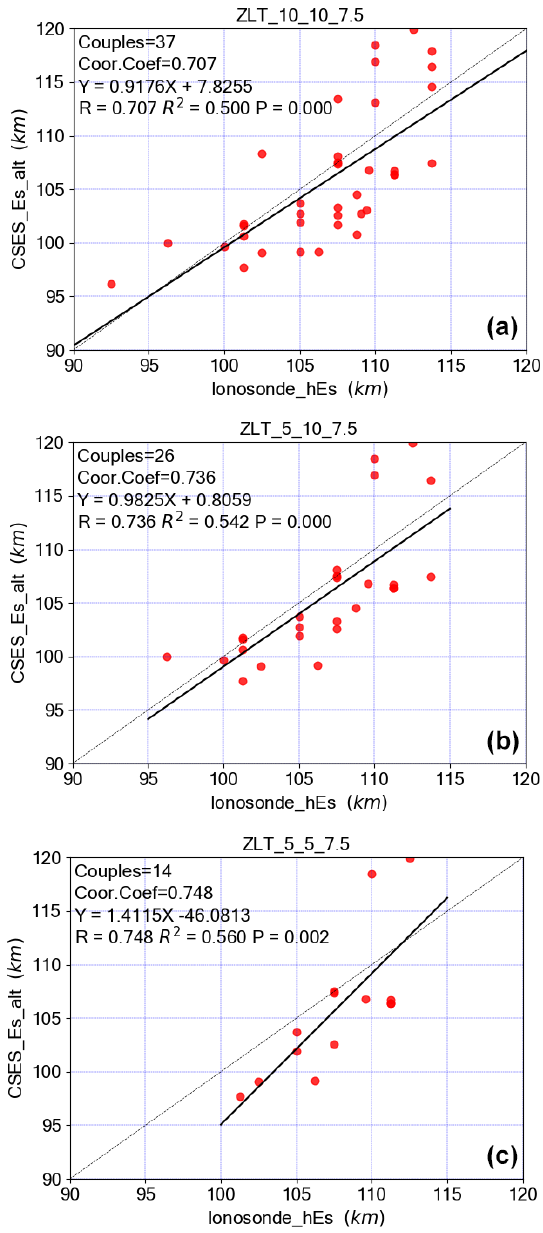
Figure 8. Comparison of the geometric altitudes of E s detected in CSES radio occultation profiles and the virtual heights of E s ob- tained by the ZLT ionosonde. Panels (a–c) are the results of space- time matching window (10 ◦ , 10 ◦ , 7.5min), (5 ◦ , 10 ◦ , 7.5min), and (5 ◦ , 5 ◦ , 7.5min), respectively. The black solid line is the regression